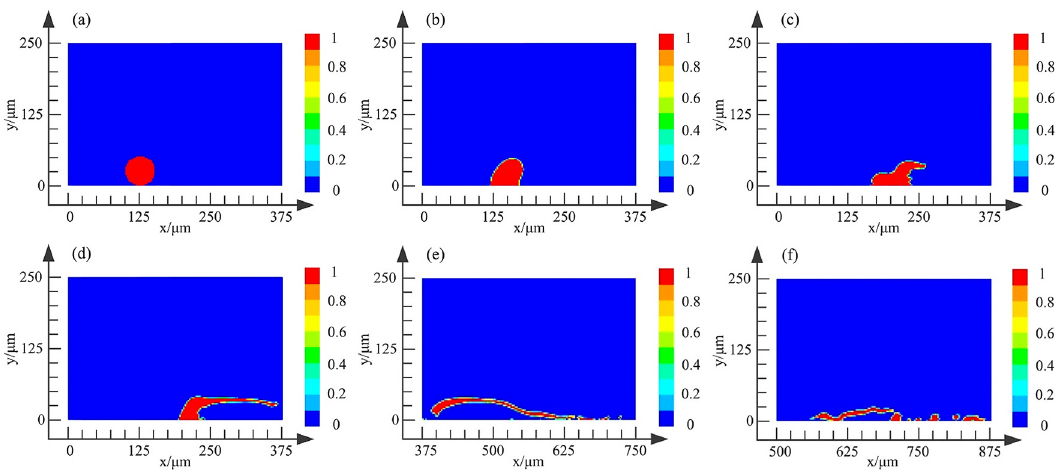
Figure 11. Volume fraction profiles of the bubble bursting on the wall: ( a ) t = 0 µ s, ( b ) t = 13 µ s, ( c ) t = 48 µ s, ( d ) t = 64 µ s, ( e ) t = 74 µ s, ( f ) t = 91 µ s.